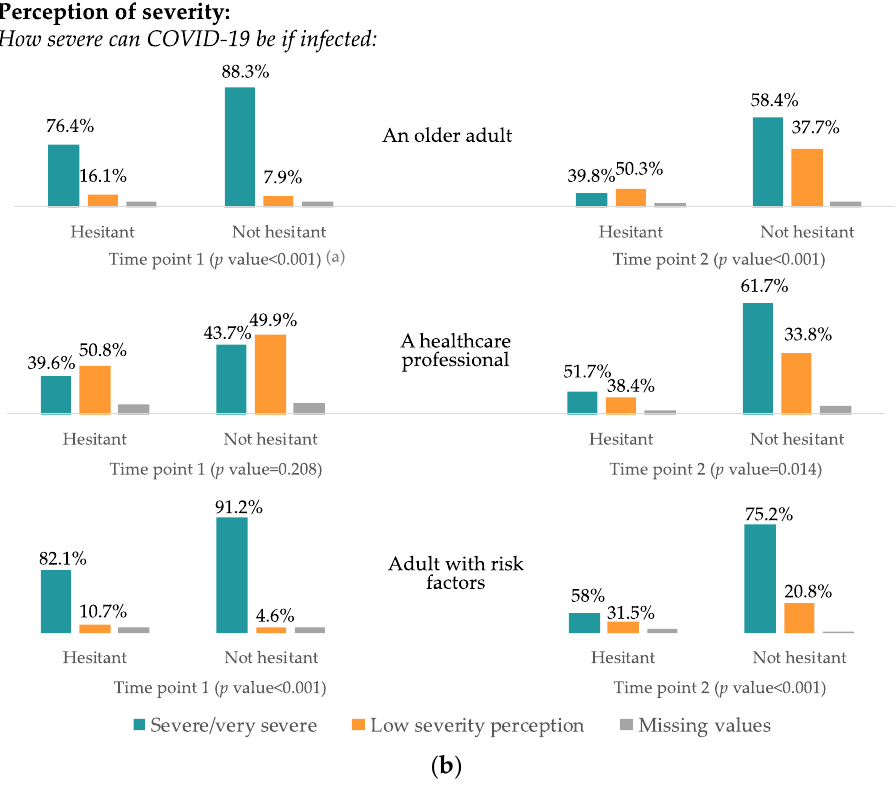
Figure 2. ( a ) Disease’s perception of risk: probability of infection, by hesitancy and time period. COVID-19 Vaccine Hesitancy Study. Barcelona. 2020–2021. ( a ) Chi square test between hesitant and non-hesitant nurses does not include missing values. Chi square test between time points were <0.001 for the three variables. Bar graphs present the absolute frequency between each group studied (you, patients or cohabitants) in both submissions, while the percentage frequency presents the risk perception separately in each group of nurses, according to VH or non-VH. ( b ) Disease’s perception of risk: perception of severity, by hesitancy and time point. COVID-19 Vaccine Hesitancy Study. Barcelona, 2020–2021. ( a ) Chi square test between hesitant and non-hesitant nurses does not include missing values. Chi square test between time points were <0.001 for the three variables. Bar graphs present the absolute frequency between each group studied (an older adult, a HCW or an adult with risk factors) in both submissions, while the percentage frequency presents the risk perception separately in each group of nurses, according to VH or